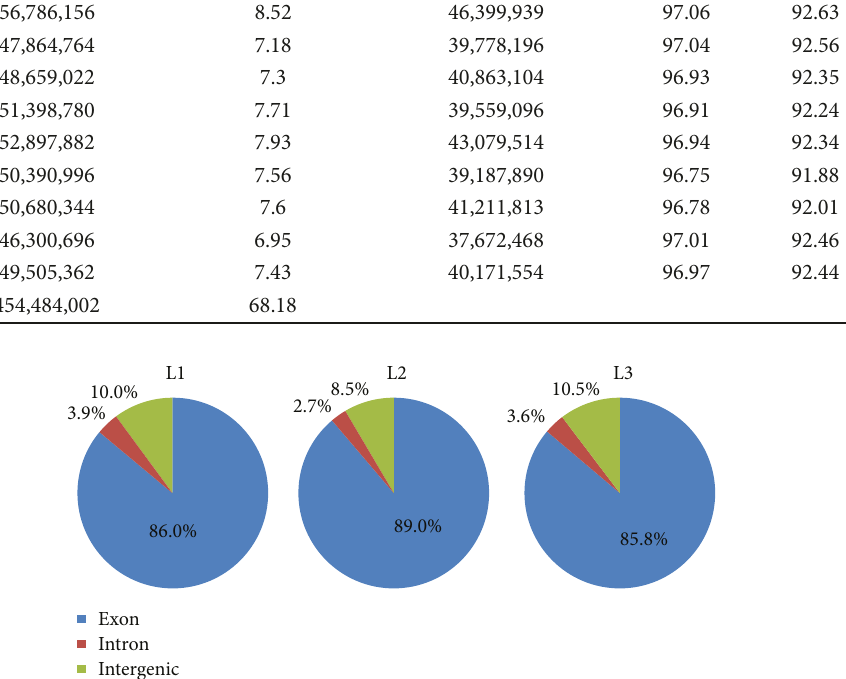
Figure 2: Distribution of reads in di ff erent regions of the genome in three periods.